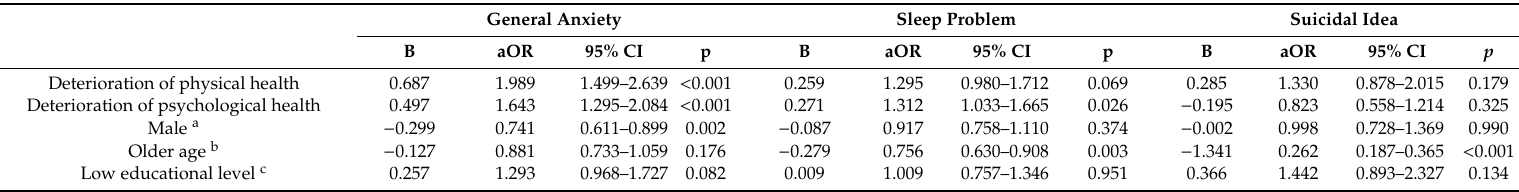
Table 5. Association between the deterioration of physical and psychological health and general anxiety, sleep problems, and suicidal ideation. General Anxiety Sleep Problem Suicidal Idea B aOR p Deterioration of physical